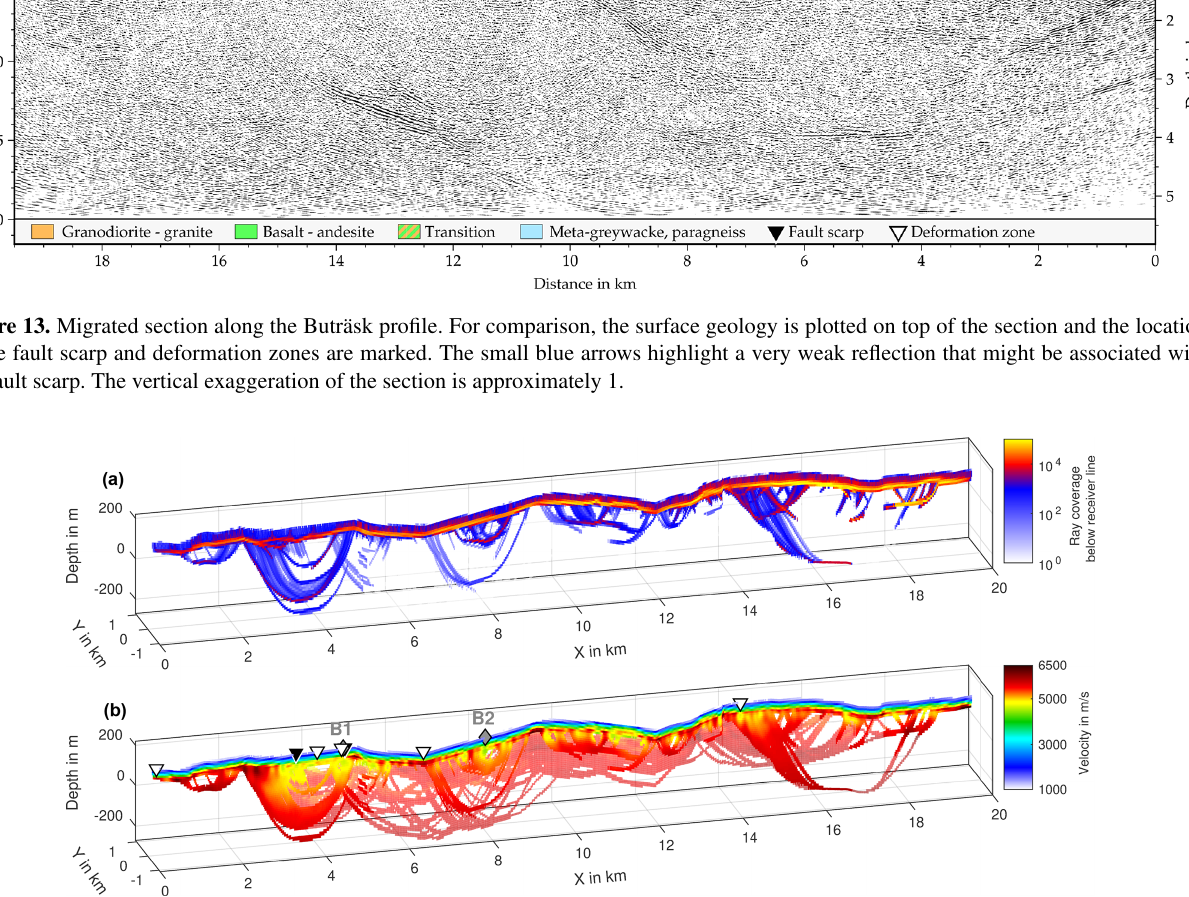
Figure 14. A 2-D slice of the ray coverage and the velocity model from the first-break tomography. Panel (a) shows the ray coverage in a 100m wide zone below the receiver line. Panel (b) displays the velocity below the receiver line in bright colors. In areas without velocity information below the receiver line, the average of the velocity model in the y direction is plotted in dim colors. The black triangles mark the location of the fault scarp, the white triangles indicate deformation zones and the grey diamonds correspond to the surface projection of reflections B1 and B2. The vertical exaggeration of the model section is